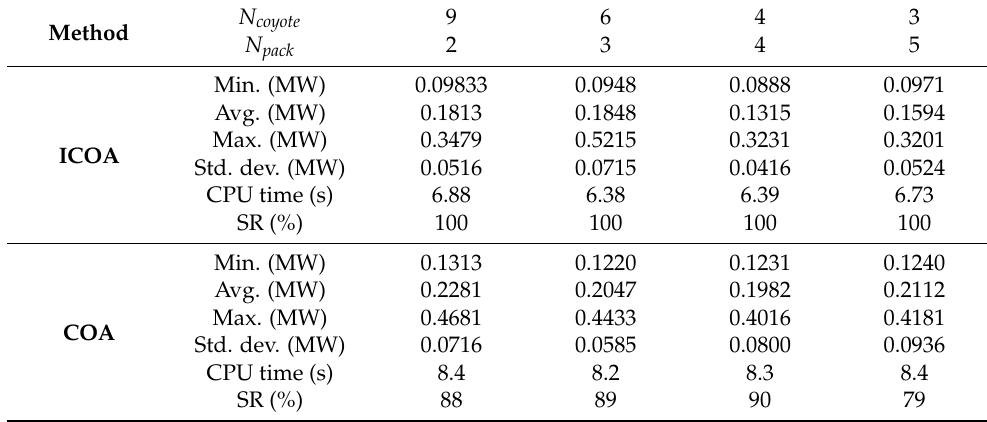
Table 3. Results found by the proposed ICOA approach for TVD objective of the IEEE 30-bus system. N Method